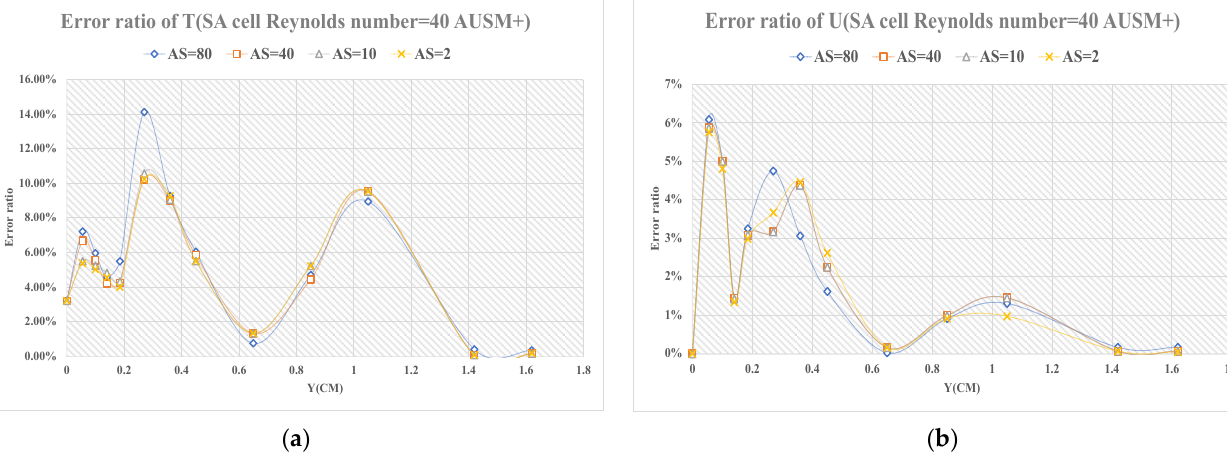
( b ) Figure 21. ( a ) ratio distribution diagrams between T and TINF at S = 0.105 m; ( b ) ratio distribution diagrams between U and UINF at S = 0.105 m.